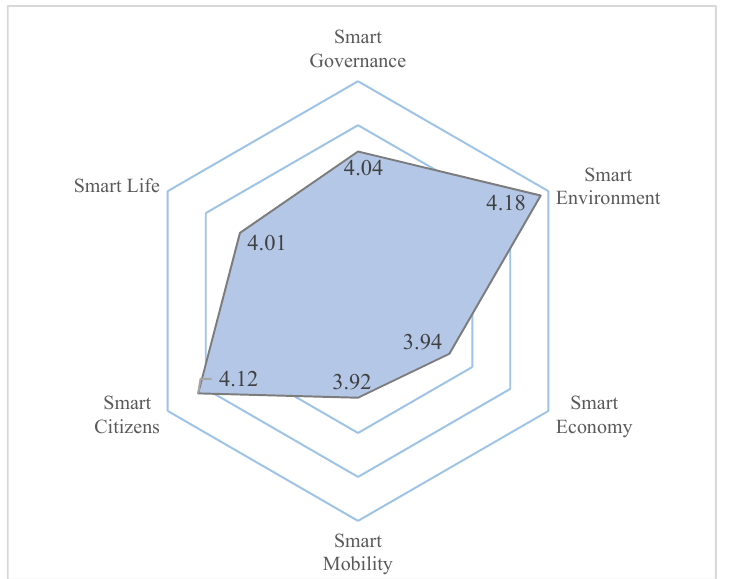
Figure 4. The weight of six driving factors on smart city construction in developing countries (revised from [51]).